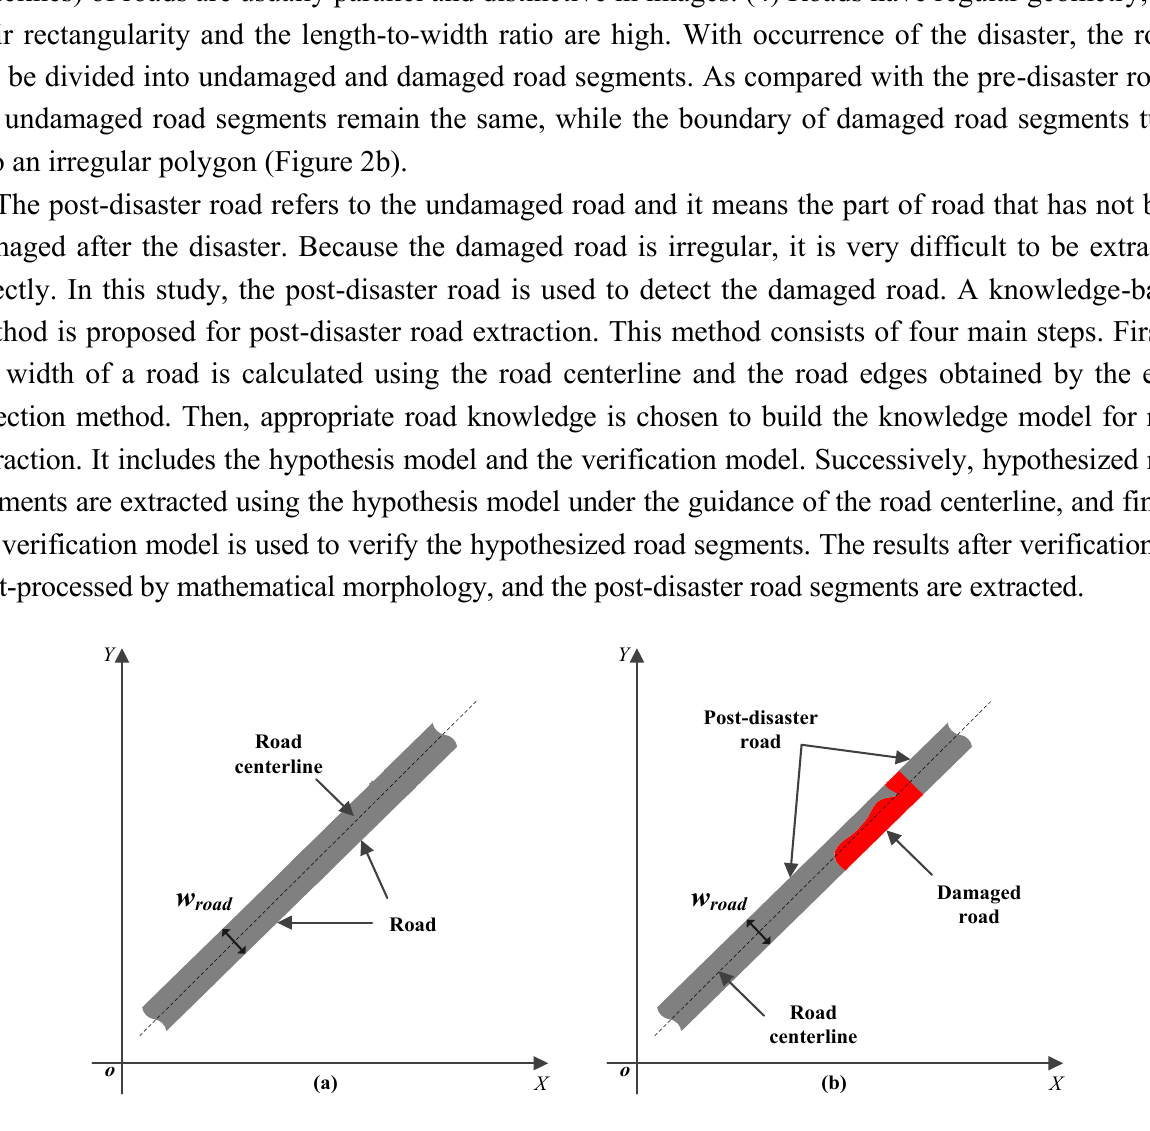
Figure 2. The diagram of road. ( a ) The road before disaster; ( b ) The road after